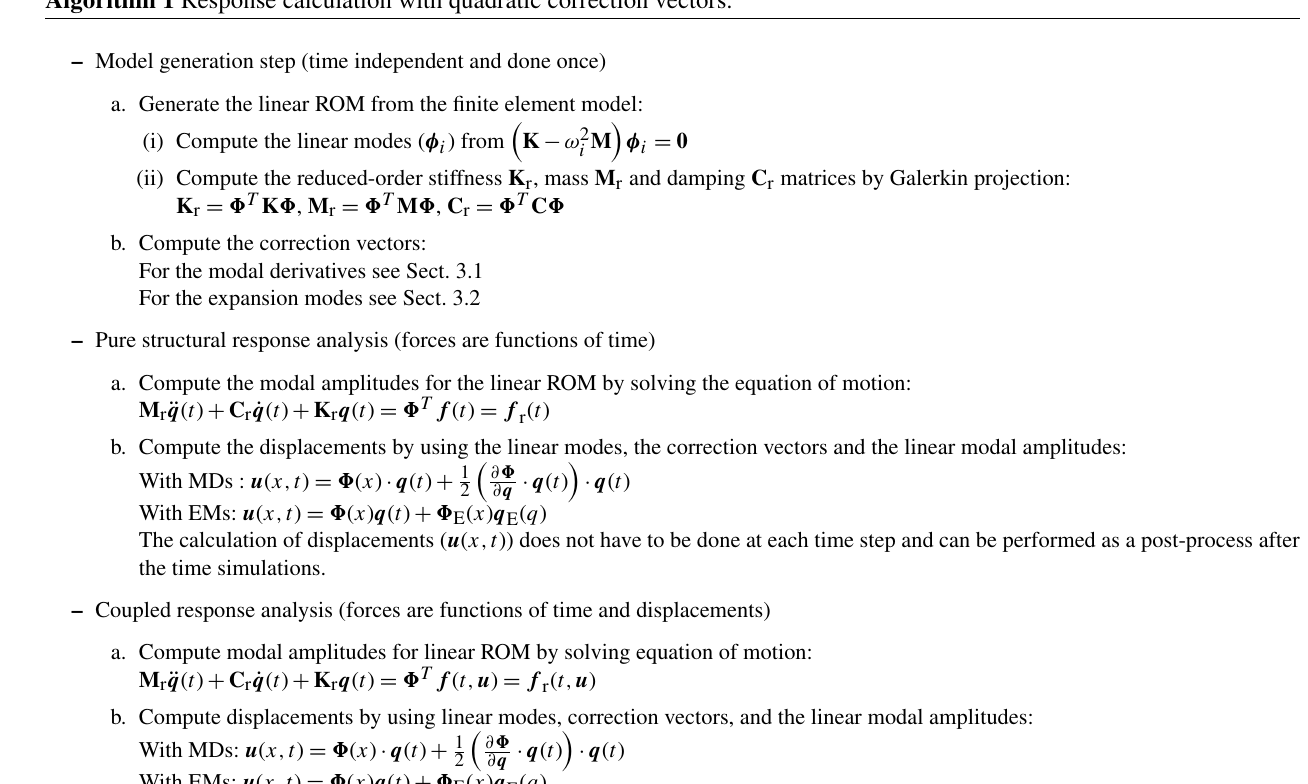
Algorithm 1 Response calculation with quadratic correction vectors.